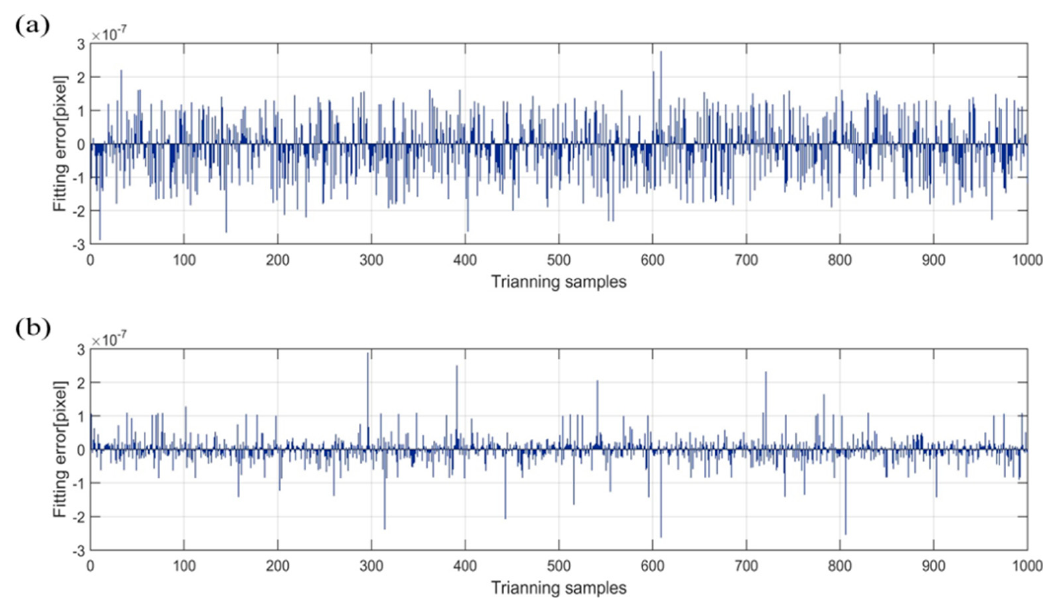
Figure 9. The fitting error of the BA-ELM compensation method. ( a ) Gaussian width σ PSF = 0.3. ( b ) Gaussian width σ PSF = 0.671.